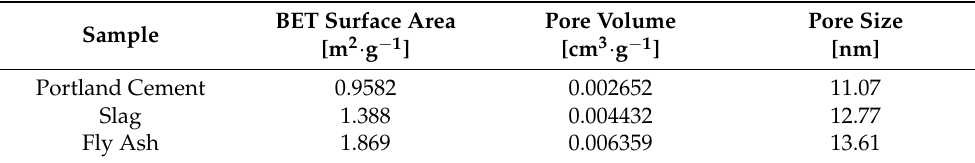
Table 2. The BET surface area, pore size, and pore volume of Portland cement, fly ash, and slag.